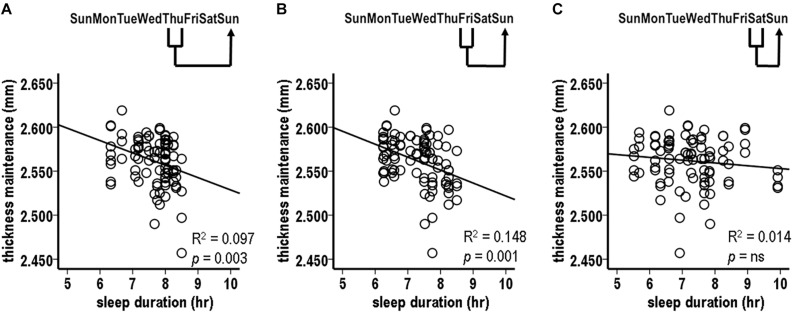
Relationships between preceding sleep durations and subsequent thickness maintenances from tests comparing sleep durations for preceding (A) Thursday, (B) Friday, and (C) Saturday individual nights vs. thickness maintenances on subsequent Sundays. Fluctuations in sleep durations for preceding Thursday (A) and Friday (B) nights were significantly inversely related to subsequent thickness maintenance.